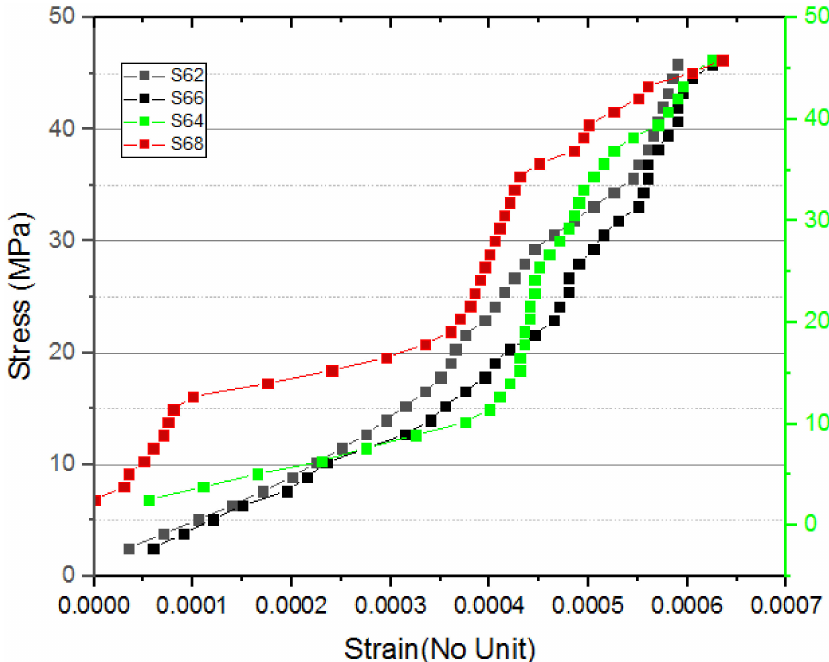
Figure 14. Stress–strain curve for S62 to S68.